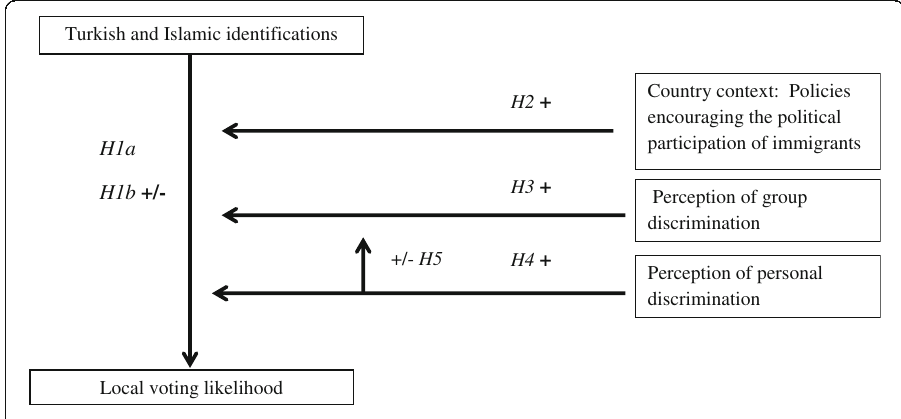
Fig. 1 Hypotheses. It shows the main concepts of the article (e.g. Turkish identification), the presumed direction of the effects and the moderators (e.g. perception of group